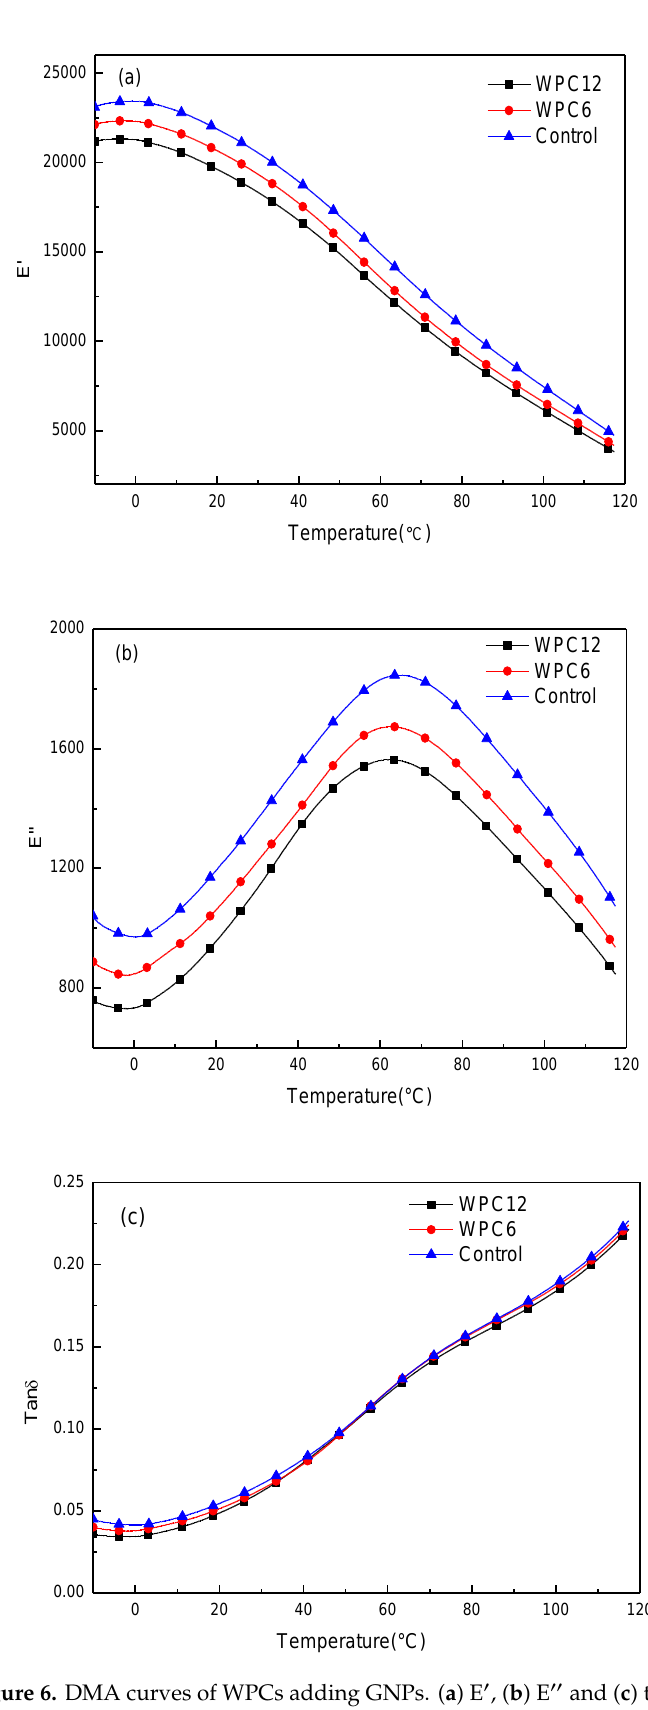
Figure 6. DMA curves of WPCs adding GNPs. ( a ) E (cid:48) , ( b ) E (cid:48)(cid:48) and ( c ) tan δ